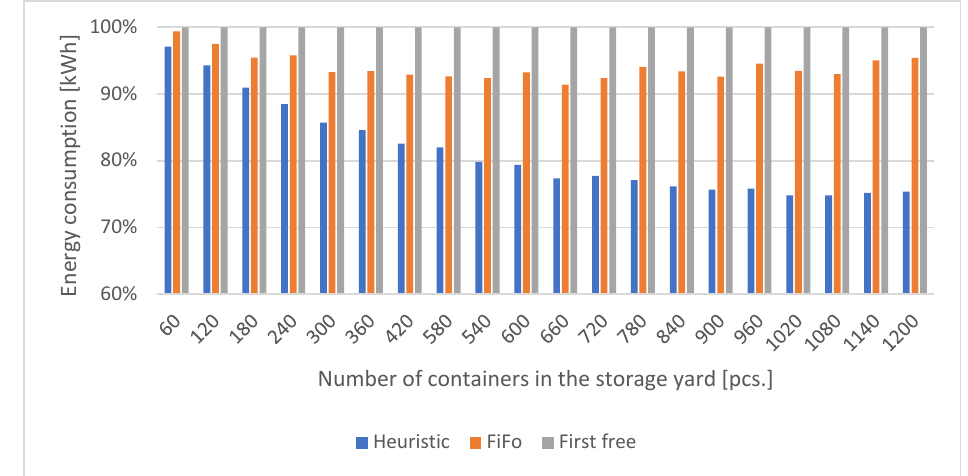
Figure 8. Energy savings due to different methods. Source: [own elaboration].